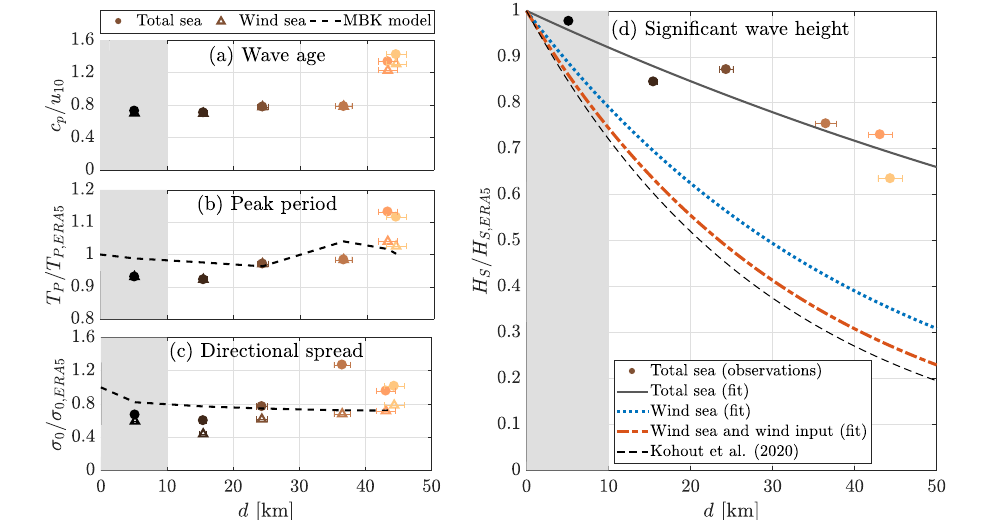
Fig. 5| Wavepropertiesatprogressivedistancesfromtheiceedge.a Wave age; b peakperiod; c directionalspreading;and d signi fi cantwaveheight(verticalaxes) versus distance (horizontal axes). Dots are used to denote total sea, and triangles the wind sea (total sea without swell). The horizontal error bars denote uncer- taintiesindistancefromtheiceedgeduetovariabilityinwindandwavedirections. The shaded area denotes intermediate ice concentration. b , c The dashed line is